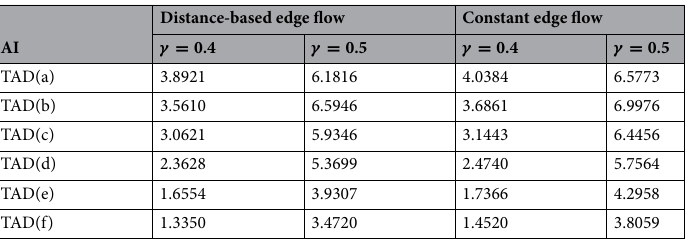
Table 2. HodgeRank-based TAD analysis. The AI values are used for the quantitative measurement of the folding within TAD. A larger AI value indicates more loops and high compactness of TAD region. In contrast, a lower AI value means less folding and less loops within TAD. Two different edge flow models, i.e., distance-based edge flow as in Eq. (4) and constant edge flow as in Eq. (4), are considered. Two different cutoff distances, i.e., γ = 0.4 and γ = 0.5 , are used to construct Hi-C matrix-based simplicial complexes.